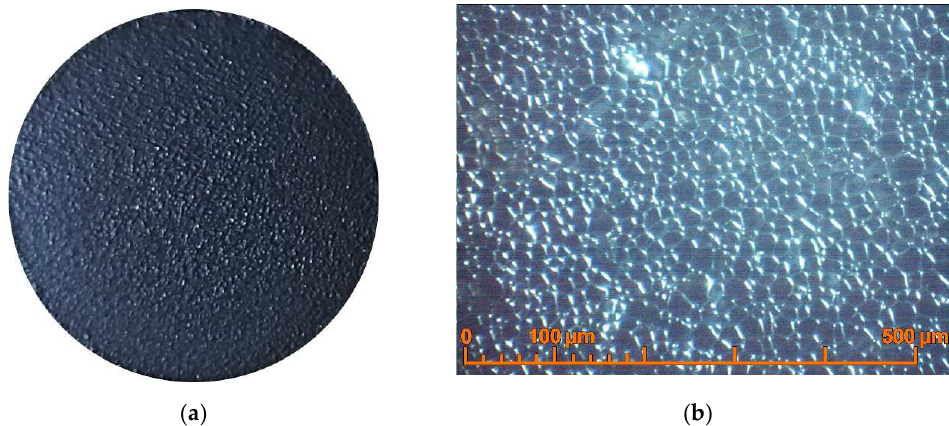
Figure 7. Surface of the BCS-CuO/SDC electrolyte layer after sintering at a temperature of 1450 °С for 5 h on the NiO-BCS-CuO anode substrate (BCS-3 sample): ( a ) the sample appearance (photo image without enlargement); ( b ) optical image.